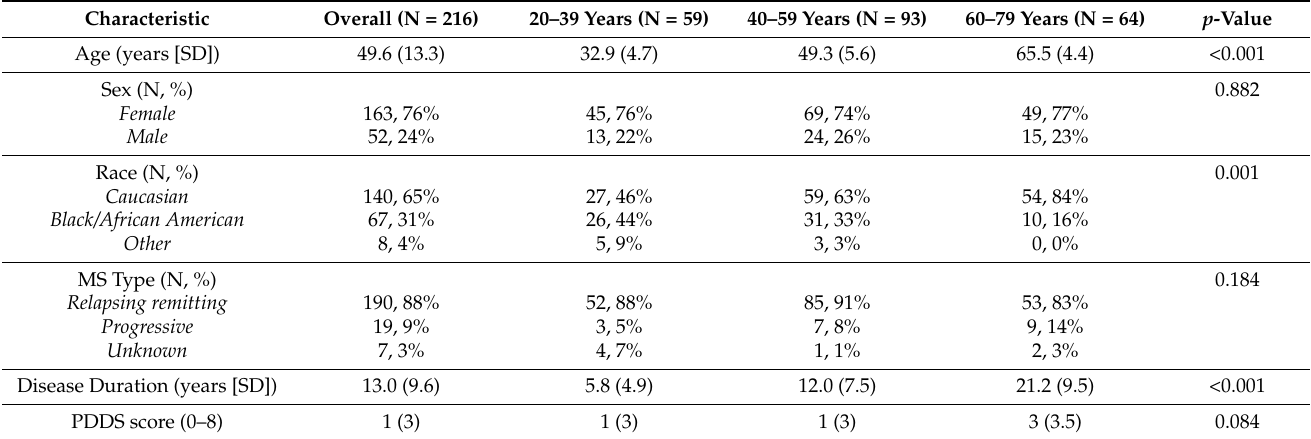
Table 1. Demographic and clinical characteristics of the overall sample and subsamples per age group of persons with multiple sclerosis